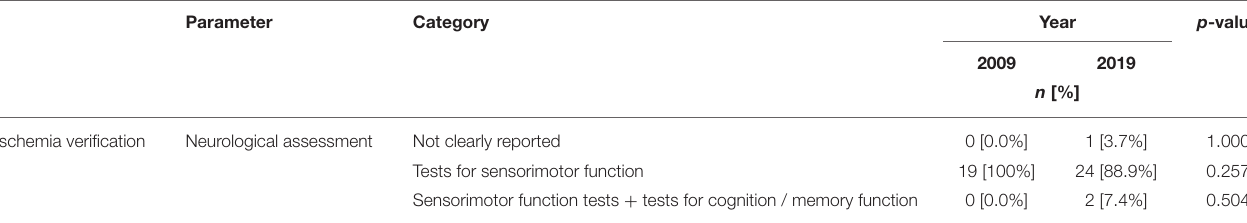
TABLE 3 | Neurological assessments extracted from the studies included in the review. Parameter